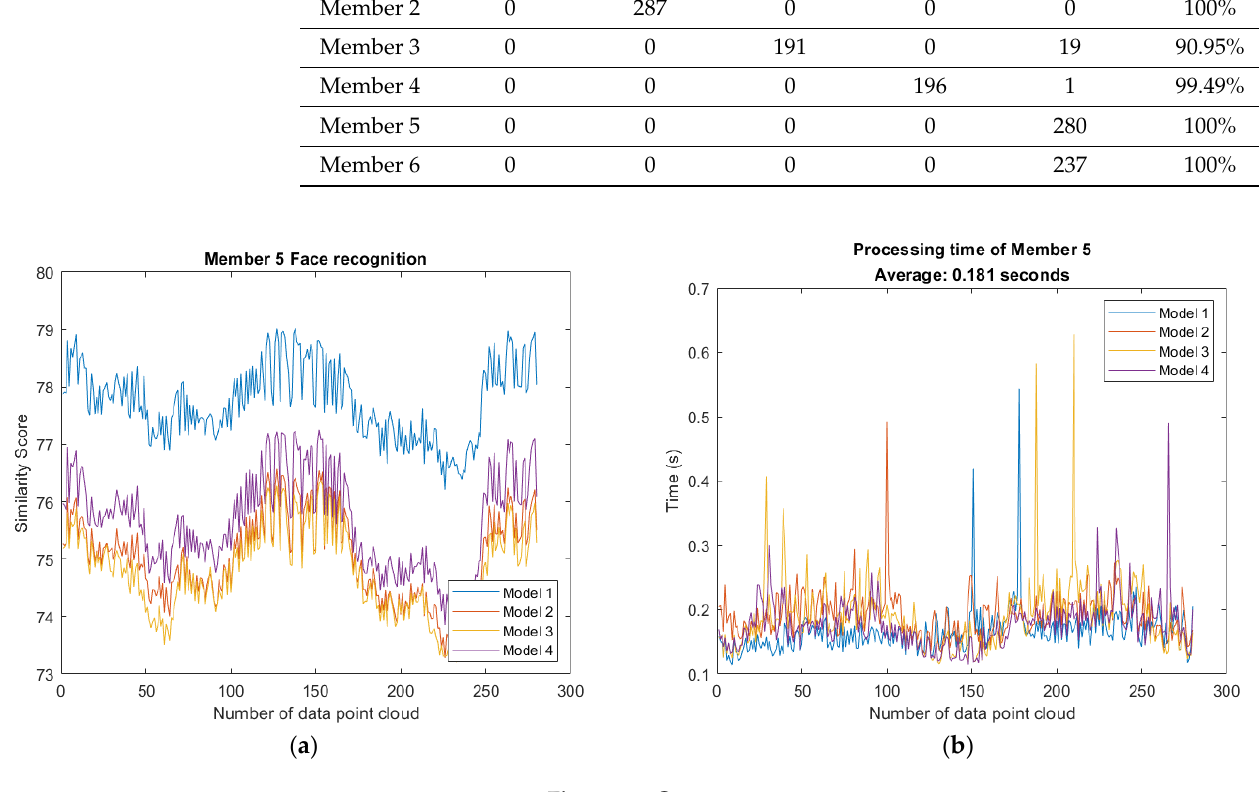
Figure 24. Result of 3D face recognition: ( a ) 12 frames of Member 1 are recognized as none; ( b ) computation time of each frame with Member 1; ( c ) every Member 2 data set is recognized as Model 2; ( d ) computation time of each frame with Member 2; ( e ) 19 frames of Member 3 are recognized as none; ( f ) computation time of each frame with Member 3; ( g ) only one frame of Member 4 is misclassified as none; ( h ) computation time of each frame with Member 4.